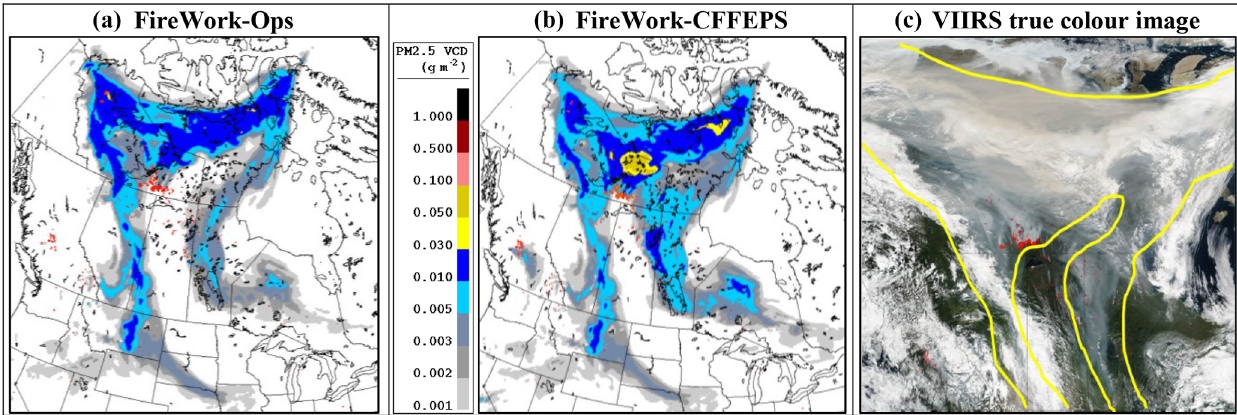
Figure 10. Fire PM 2 . 5 VCD (gm − 2 ) forecast by FireWork-Ops (a) and FireWork–CFFEPS (b) from the 13 August 2017 00:00UTC fore- cast run valid for 14 August 2017 12:00UTC and the (c) VIIRS true colour satellite image for 14 August 2017 with lines superimposed to aid comparison. Fire hotspots are represented in red. VIIRS image source: NASA (https://www.nasa.gov/image-feature/goddard/2017/ smoke-and-clouds-obscure-skies-in-northern-canada, last access: 1 October 2018)